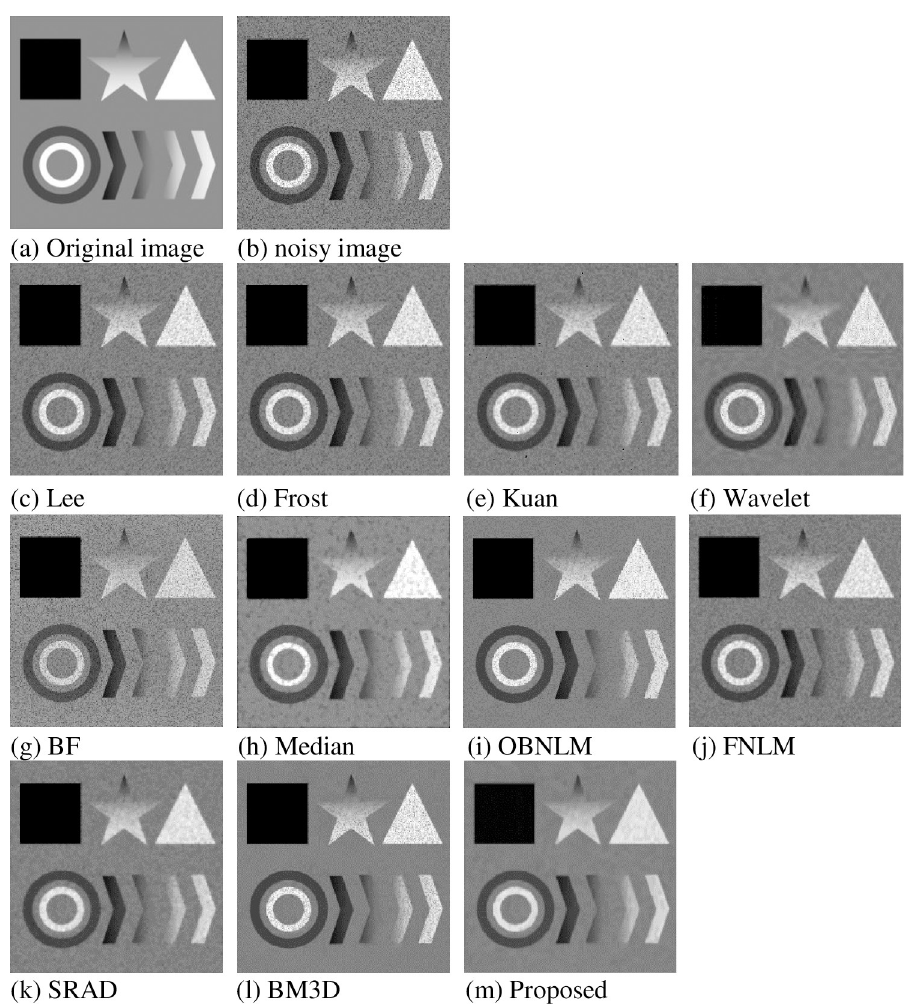
Fig 5. Composite image denoising effect diagram (variance